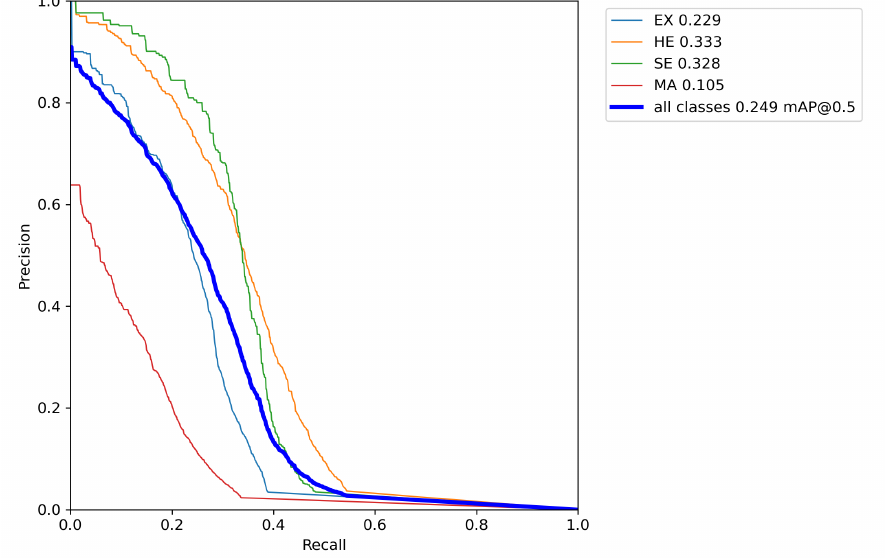
Figure 5. Graph with Precision × Recall curve with a limit of Intersection over Union of 0.5 obtained during the validation step of the proposed approach with Stochastic Gradient Descent (SGD) opti- mizer and Tilling in the Dataset for Diabetic Retinopathy (DDR). EX, hard exudates; HE, hemorrhages; SE, soft exudates; MA, microaneurysms; mAP, mean Average Precision. The x axis of the PR curve represents Recall while the y axis represents Precision . This curve mainly focuses on the performance of positive classes, which is critical when dealing with unbalanced classes. Thus, in the PR space, the goal is to be in the upper right corner ( 1, 1 ) , meaning that the predictor classified all positives as positive ( Recall = 1) and that everything that was classified as positive is true positive ( Precision =